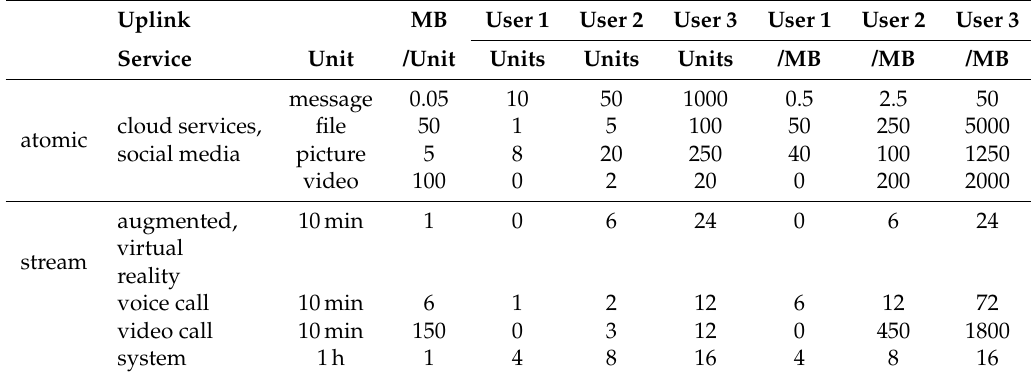
Table 1. Uplink data traffic definition for user types 1–3 (from light to heavy). Atomic transmission units are transmitted at the maximum data rate. Streaming data units are transmitted at a constant data rate for the duration of